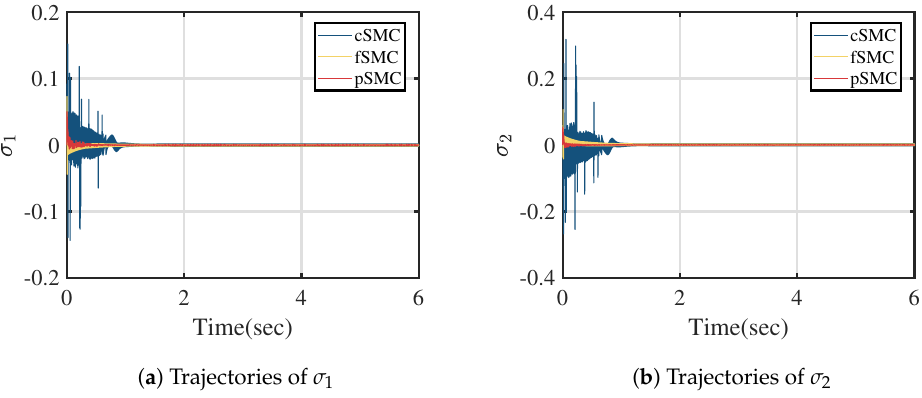
Figure 13. The trajectories of sliding variables σ 1 and σ 2 when ρ b = 0.6: cSMC (Blue solid line), fSMC (Yellow solid line) and pSMC (Red solid